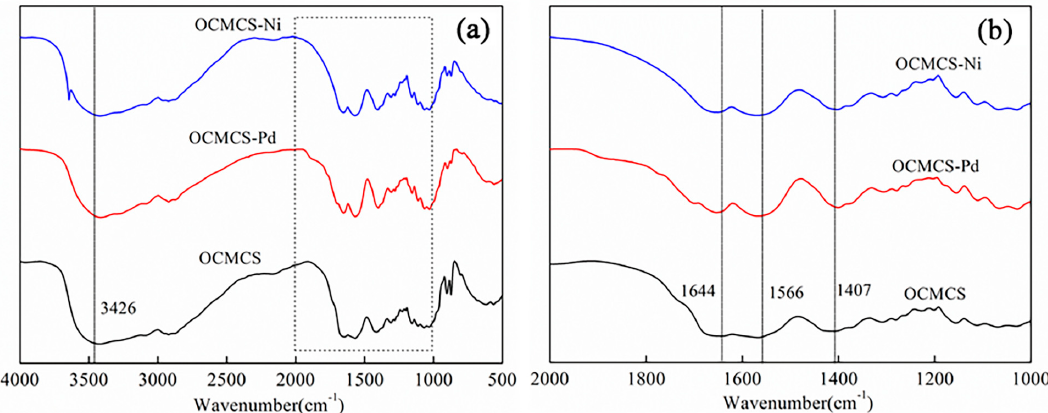
Figure 1. Fourier transform infrared (FT-IR) spectra of O -carboxymethyl chitosan (OCMCS), OCMCS-Pd, Figure 1. FT-IR spectra of O -carboxymethyl chitosan (OCMCS, black line), OCMCS-Pd (red line), OCMCS-Ni in ( a ) the wavenumber range 500–4000 cm − 1 ; and ( b ) the wavenumber range 1000–2000 cm − 1 . OCMCS-Ni (blue line) in the wavenumber range of 500–4000 cm − 1 ( a ); and the wavenumber range of 1000–2000 cm − 1 ( b